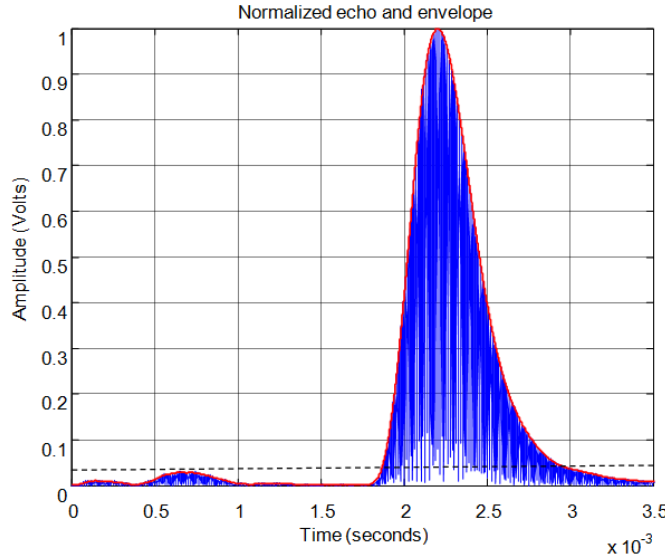
Figure 11. Normalized echo and envelope.